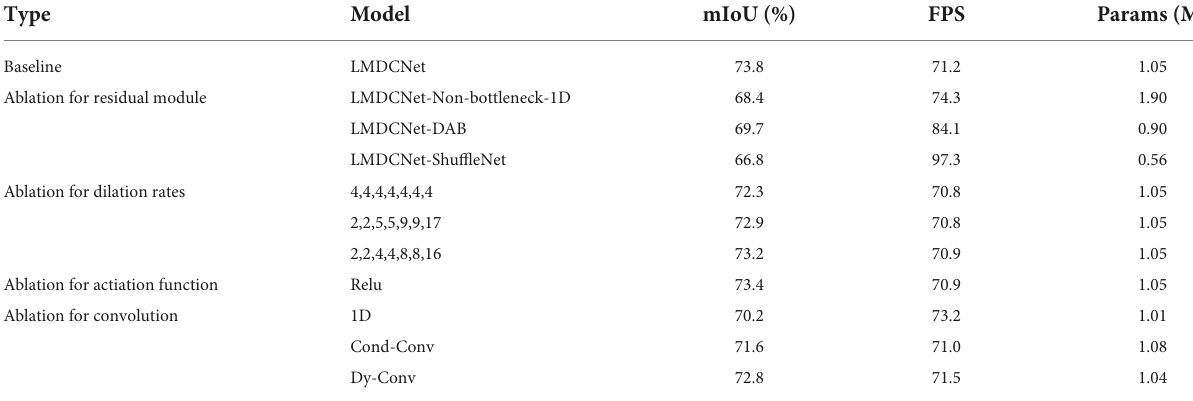
TABLE 2 Ablation study results of depth-asymmetric bottleneck module with multi-dimensional dynamic convolution and shuffling operations (MS-DAB module).